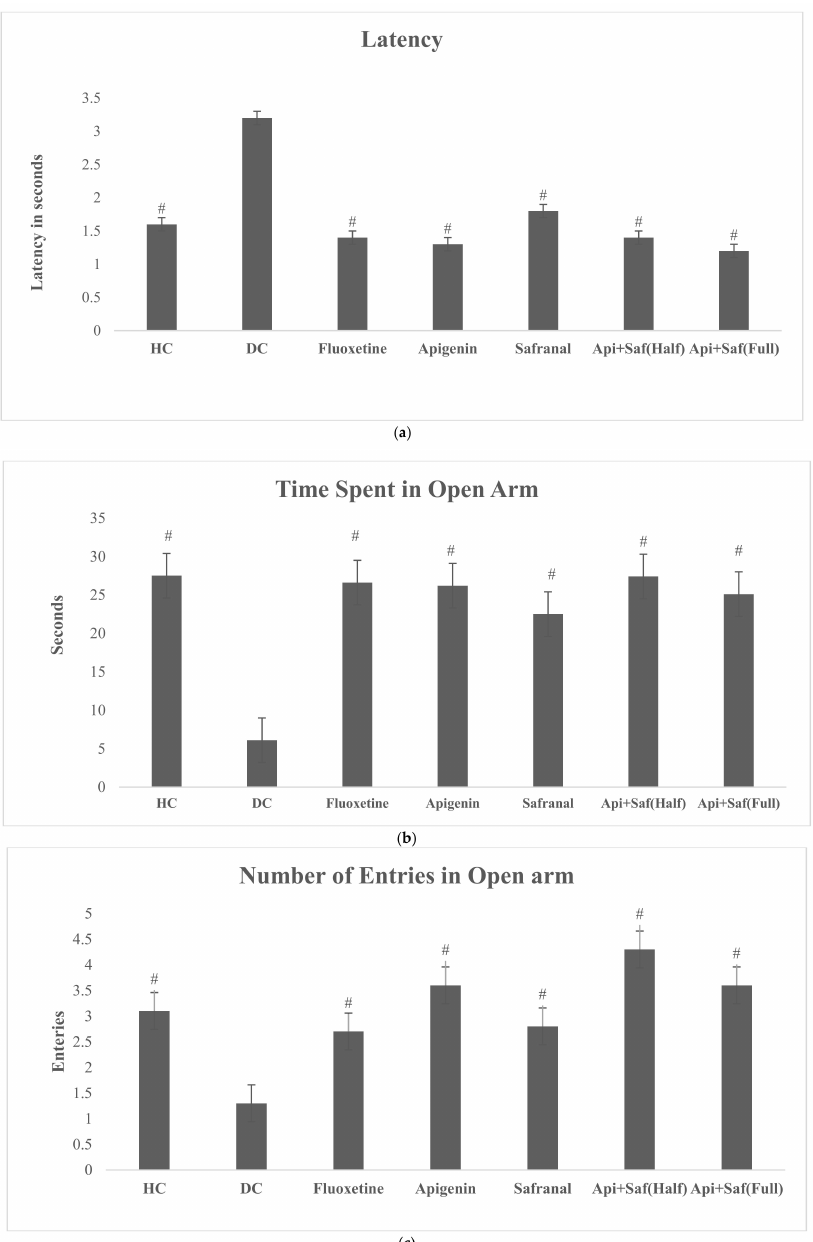
Figure 11. ( a ) Effects of three weeks of oral gavage of safranal, apigenin, and its combination on latency for EPMT in diabetic (induced) depressed rats. Values are shown as average ± SD (n = 10). One-way ANOVA was employed to analyze the results pursued by Tukey’s post hoc test. Here, # indicates significance ( p < 0.05) compared with the diabetic control (DC). Key: healthy control (HC), diabetic control (DC), apigenin (Api), and safranal (Saf). ( b ) Effects of three weeks of oral gavage of safranal, apigenin, and its combination on time spent in open arm for EPMT in diabetic (induced) depressed rats. Values are shown as average ± SD ( n = 10). One-way ANOVA was used to analyze the results, pursued by Tukey’s post hoc test. Here, # indicates significance ( p < 0.05) compared with diabetic control (DC). Key: healthy control (HC), diabetic control (DC), apigenin (Api),